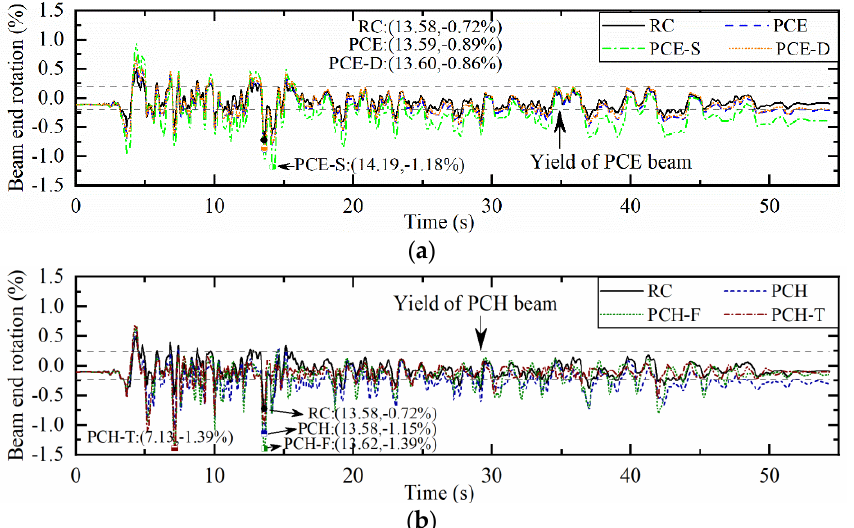
Figure 15. Time history of the rotation angle at beam end of top floor under Wave 4 (PGA: 600 gal): ( a ) Comparison between emulated frames and the RC frame; ( b ) Comparison between non-emulated frames and the RC frame.